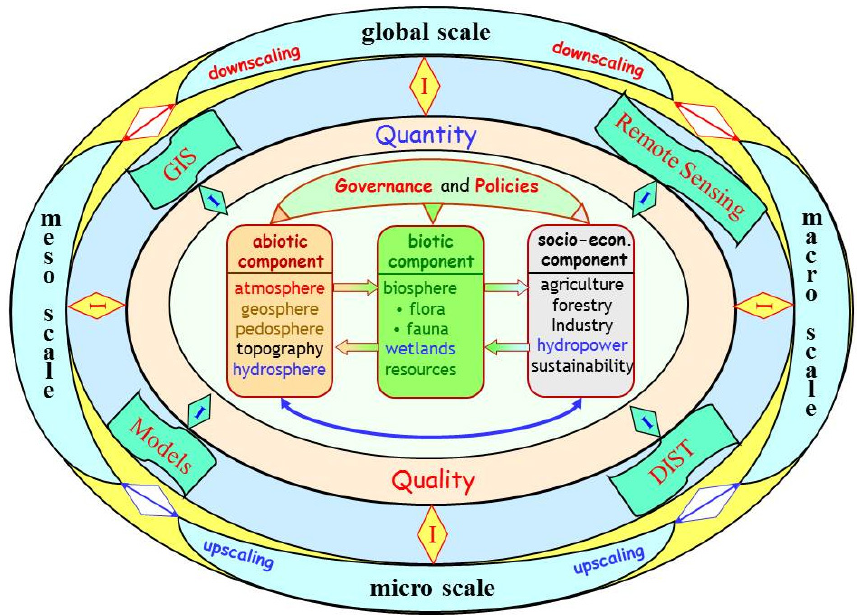
Figure 3. Holistic system approach applying integrated methods from